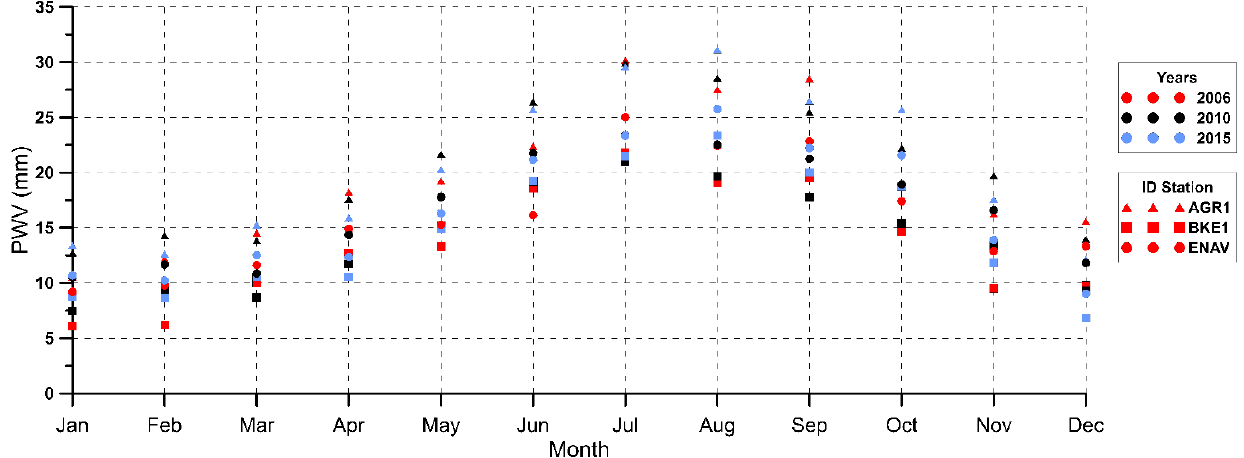
Figure 4. Monthly variability in different years of PWV at three stations of the NeVoCGPS, located at heights ranging between 70 m (AGR1) and 864 m (BKE1) a.s.l.